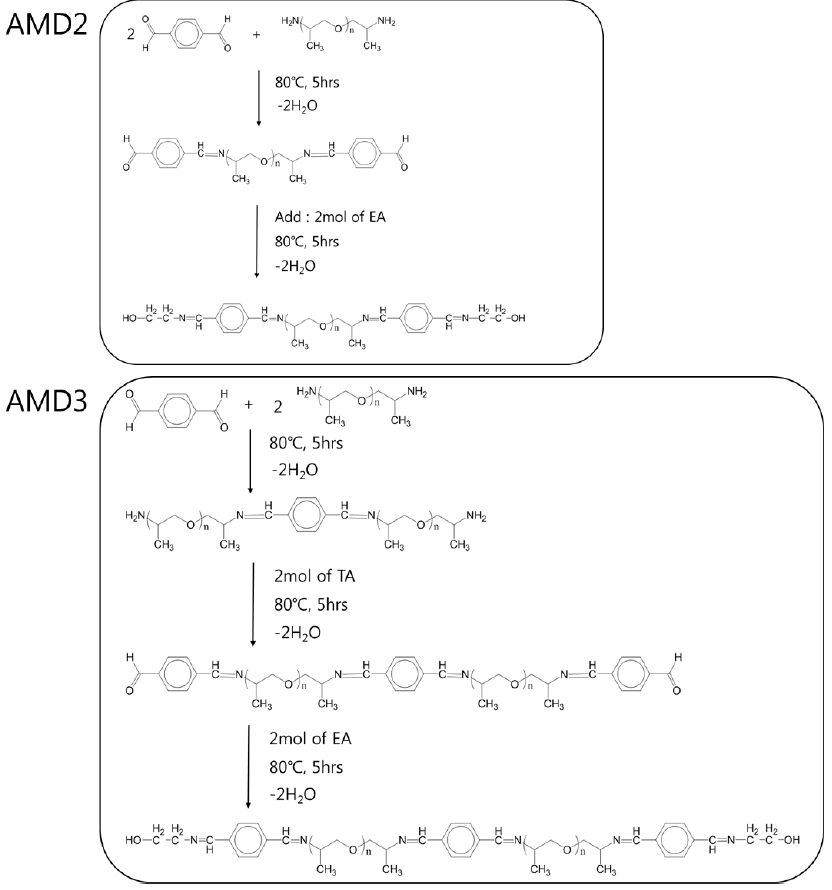
Scheme 1. Synthetic processes and structures of AMD2 and AMD3.